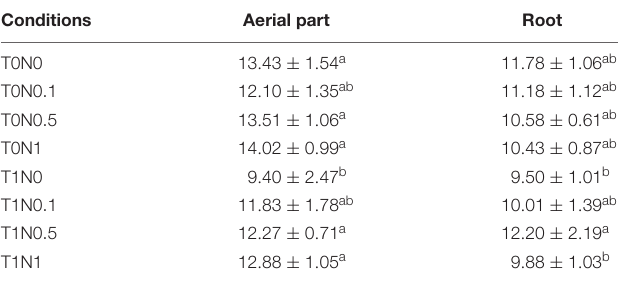
for 48 h under eight different conditions: with or without Trichoderma harzianum T34 and 0, 0.1, 0.5, or 1 mM calcium nitrate as nitrogen source.